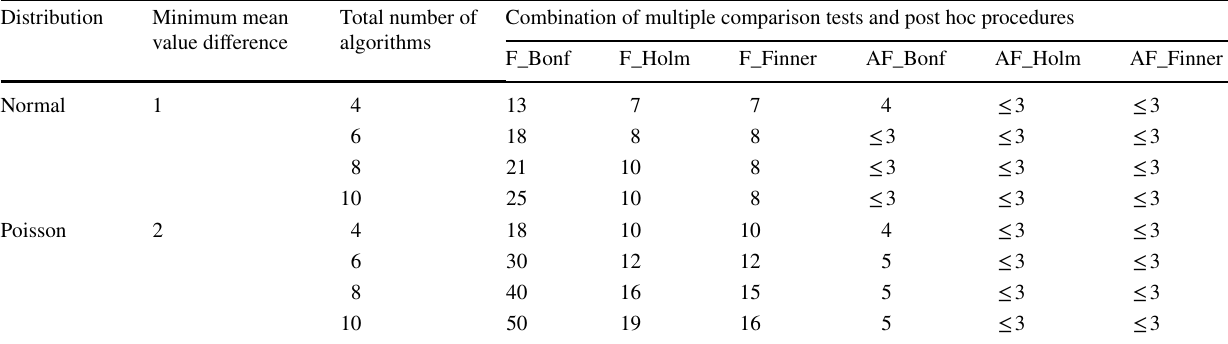
Table 6 The minimum number of datasets required by different nonparametric statistical tests for rejecting the null hypothesis with a signifi- cance level of 0.05, under the experimental settings iv and viii